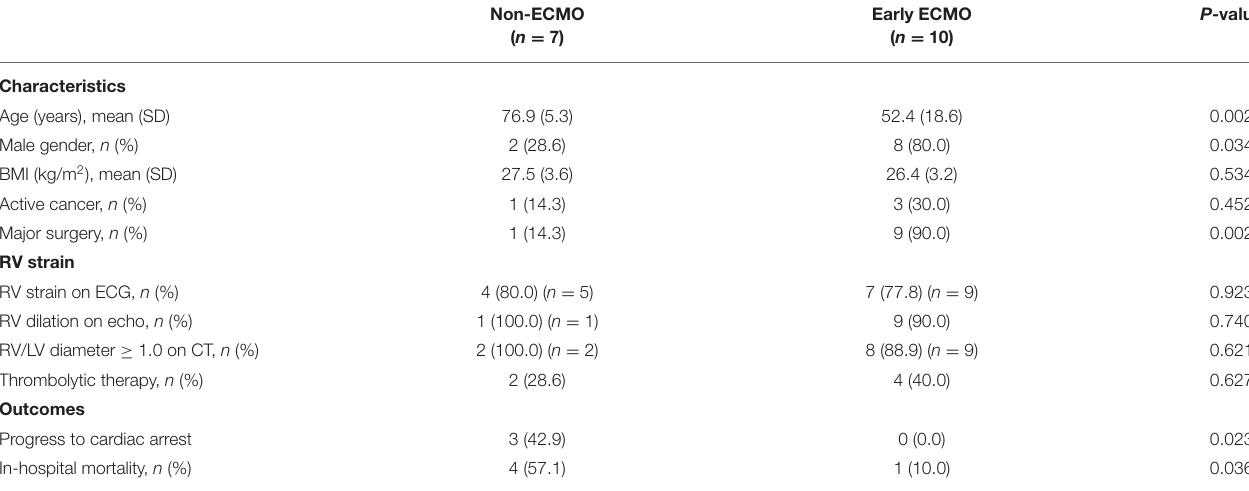
TABLE 4 | Demographic characteristics, management and outcomes in subgroup ( n = 17).